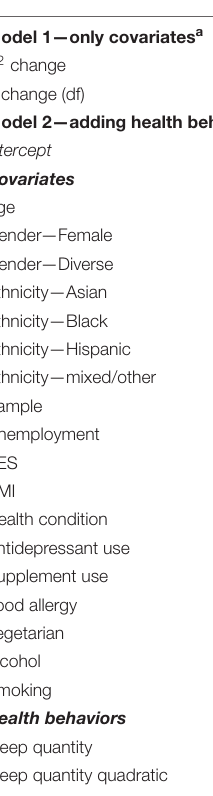
TABLE 3 | Hierarchical regression models predicting depressive symptoms and flourishing ( n = 1,111). Depressive symptoms B , b (SE) Flourishing B , b